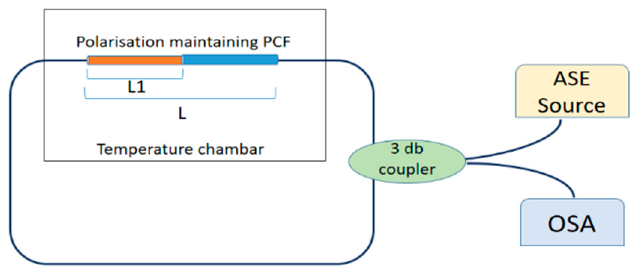
Figure 7. Schematic diagram of the optical fiber Sagnac interferometer-based temperature sensor; here L is the full length and L 1 is the infiltration length of PM-PCF in this fiber loop (Figure courtesy of reference [42]).